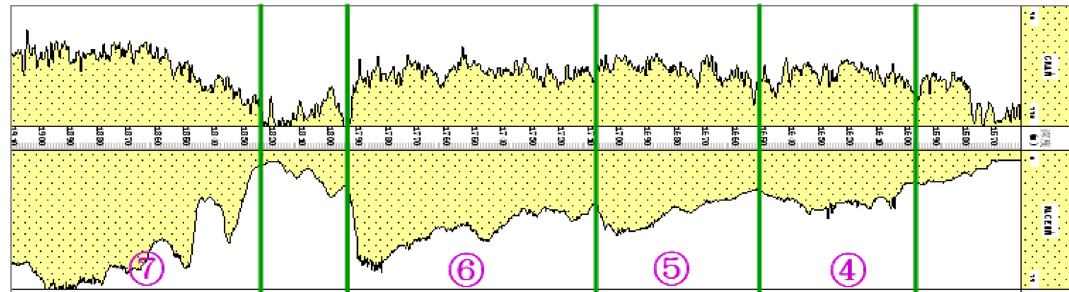
Fig. 15 The internal configuration of the point bar sand body of Well